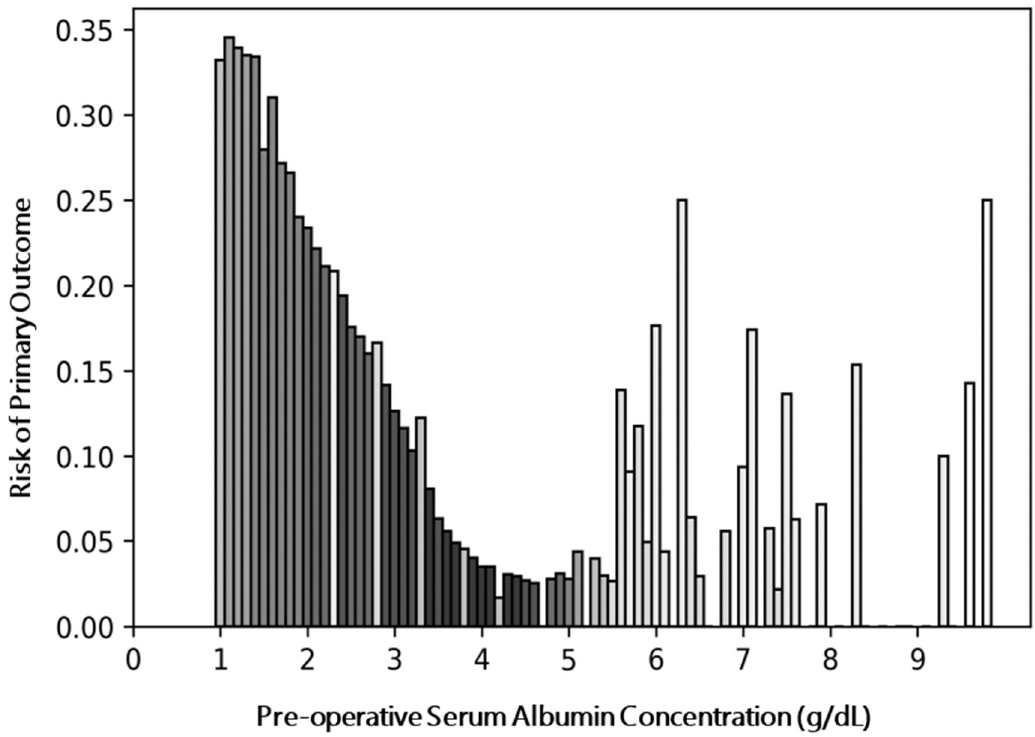
Figure 3. Unadjusted Risk of Composite Primary Outcomes as a Function of Preoperative Serum Albumin—The composite risk of primary outcomes was calculated after binning the cohort according to serum albumin concentration in steps of 0.1 g/dL. Bar shading corresponds to the number of patients in each bin, with darker shades indicating more patients and lighter shades indicating fewer patients. Table 3. Crude Rates of Surgical Outcomes.